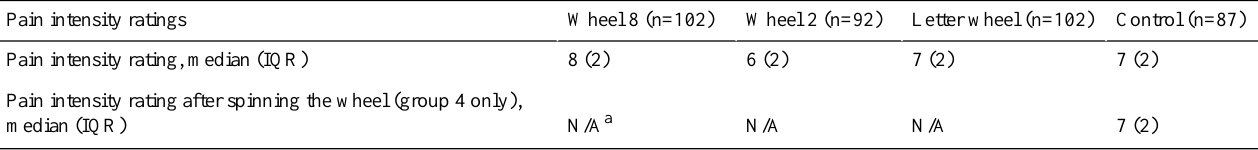
Table 1. Numeric rating scale pain intensity scores for the four groups.